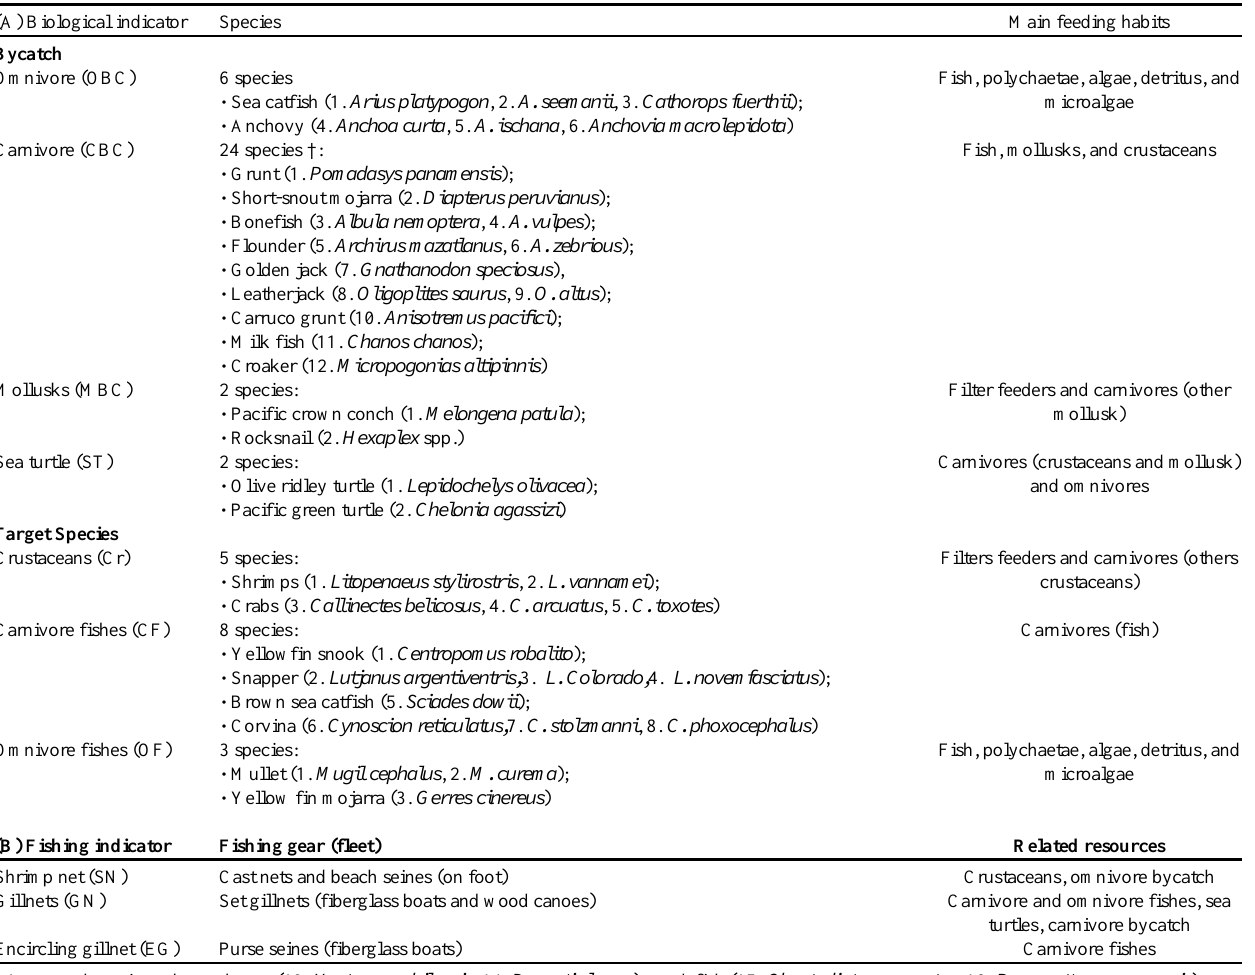
Table 3 . Traditional ecological knowledge related to (A) biological (state) and (B) fishing (pressure) indicators selected for the Huave Lagoon System, Mexico. The seven biological indicators were grouped into bycatch and target